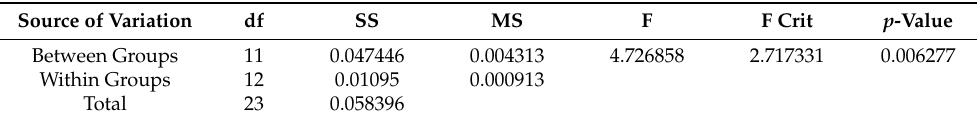
Table 6. Analysis of variance (ANOVA) of NRC on bamboo particle board which coating treatment. Source of Variation df SS MS F F Crit Between